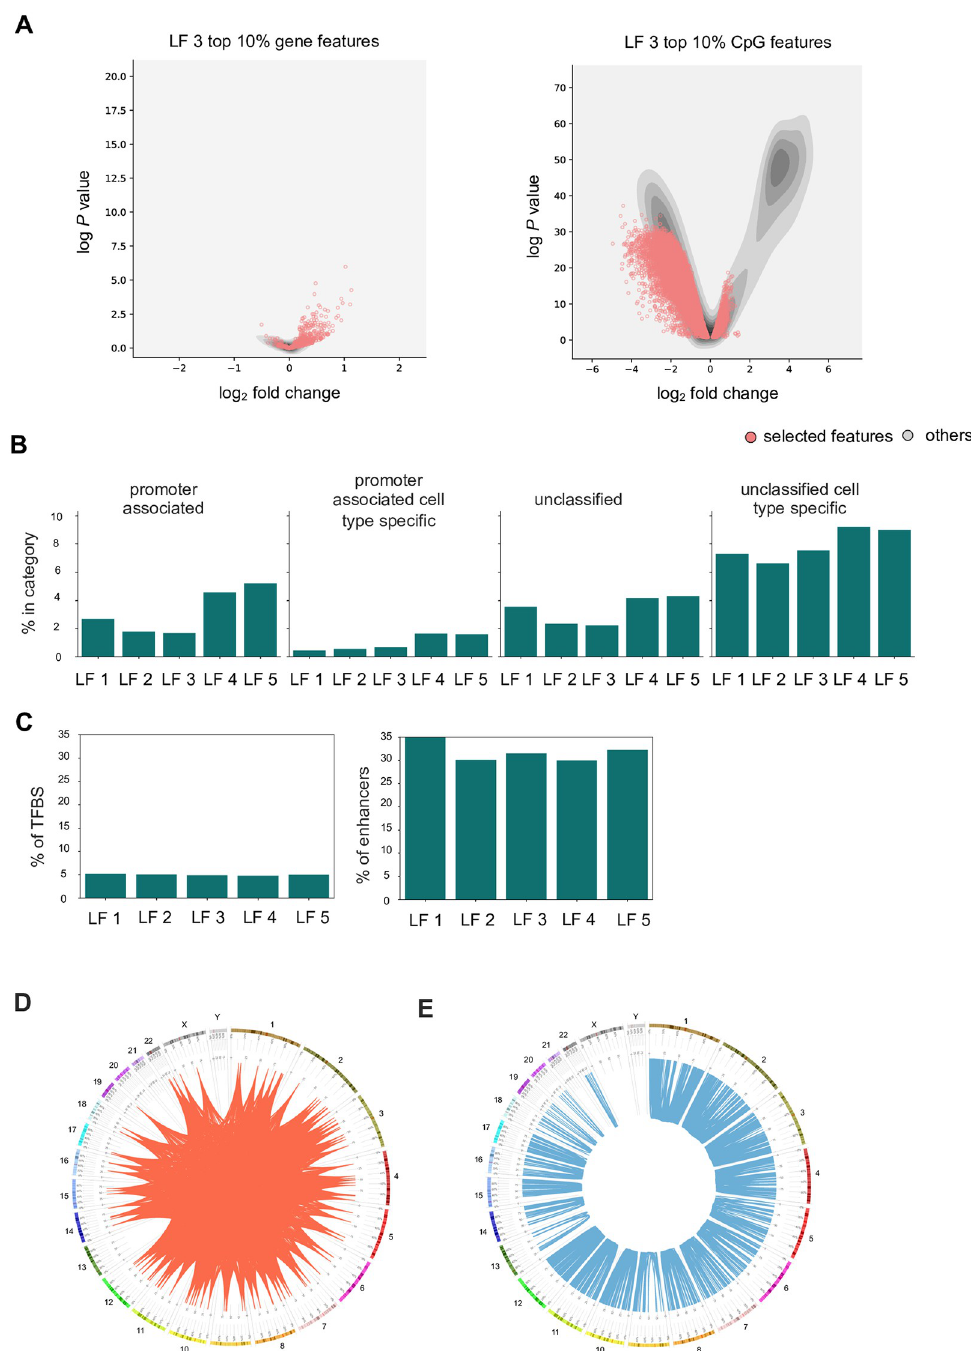
Fig 4. Characterization of features involved in correlations. A) Volcano plots showing the selected features for latent factor 3. The red dots represent the selected features which is plot against a kernel density estimate representation of all the gene/CpG features. B) The CpG sites were binned into regulatory categories of promoter associated and promoter associated cell type specific. C) For each CpG part of the selected features, the percentage of annotated enhancers and transcription factor binding sites is denoted by bar plots. D) The correlations are characterized in terms of the distance between the interacting partners, for the gene and CpG pairs derived from a latent factor analysis. The red ribbons on the CircOS plot show the connection between the interacting gene and CpG pair having a significant correlation. For this plot, top 5000 such significant correlations part of latent factor 3 were selected. E) . The correlations are characterized in terms of distance between interacting partners for m-QTL analysis. Here, the blue ribbons represent the significant correlating pairs (top 5000 randomly selected for m-QTL analysis of genes part of latent factor 3). The visualization emphasizes that the correlations obtained for latent factor analysis are distal ( trans -acting) in